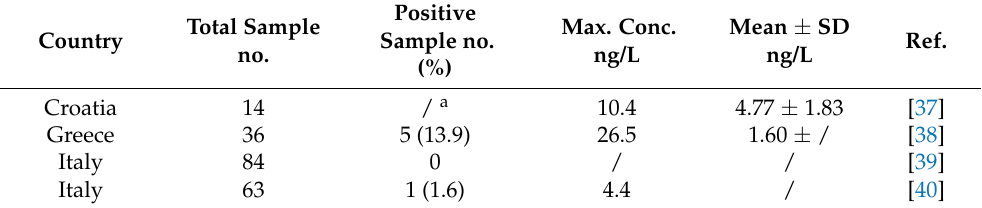
Table 4. Review of the occurrence of AFM1 in donkey milk in previous studies.